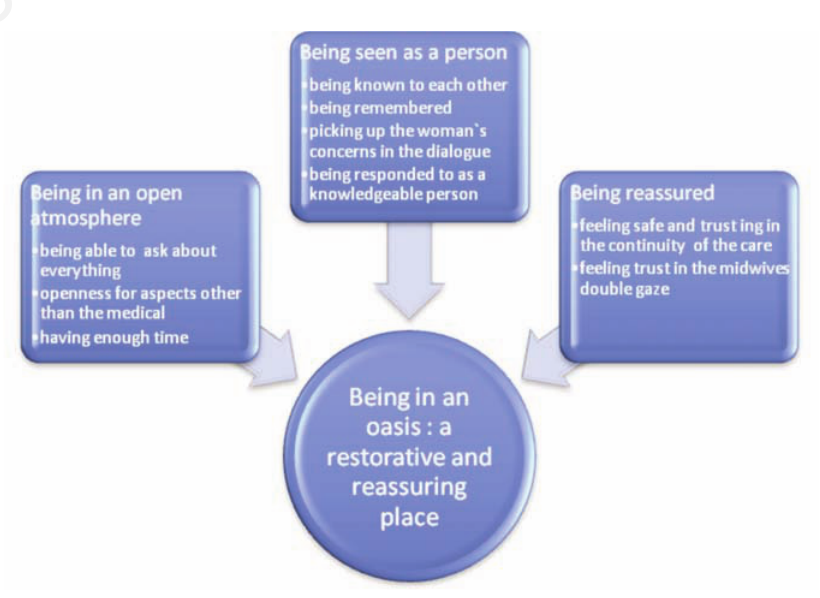
Figure 2. Interpreted understanding of the value in a midwife